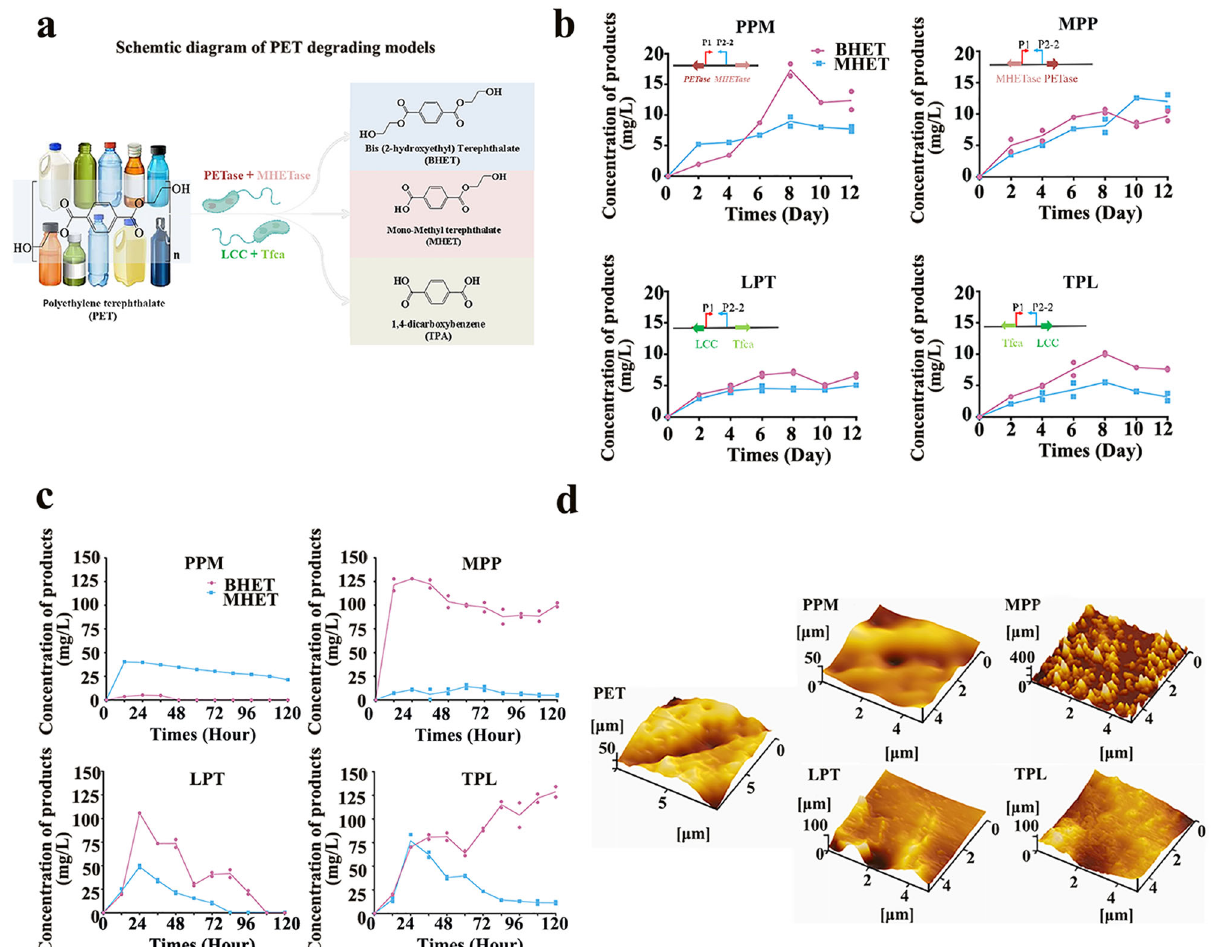
Fig. 4 Construction and characterization of the salt-induced model with promoters P1 and P2-2. a Combination of PET hydrolases for polyethylene terephthalate (PET) degradation in this work: PETase + MHETase or LCC + Tfca. b Accumulation of products mono-(2-hydroxyethyl) terephthalic acid (MHET) and bis-(2-hydroxyethyl) terephthalic acid (BHET) in the four engineered PET strains ’ whole cell degrading systems. Maps of the constructed plasmid are drawn in gray. c Accumulation of products MHET and BHET in the four engineered PET degradation strains ’ crude enzyme systems. d Changes of the surface morphology of PET membrane samples veri fi ed by an atomic force microscope (AFM) (NANOCUTE II, Seiko Instruments